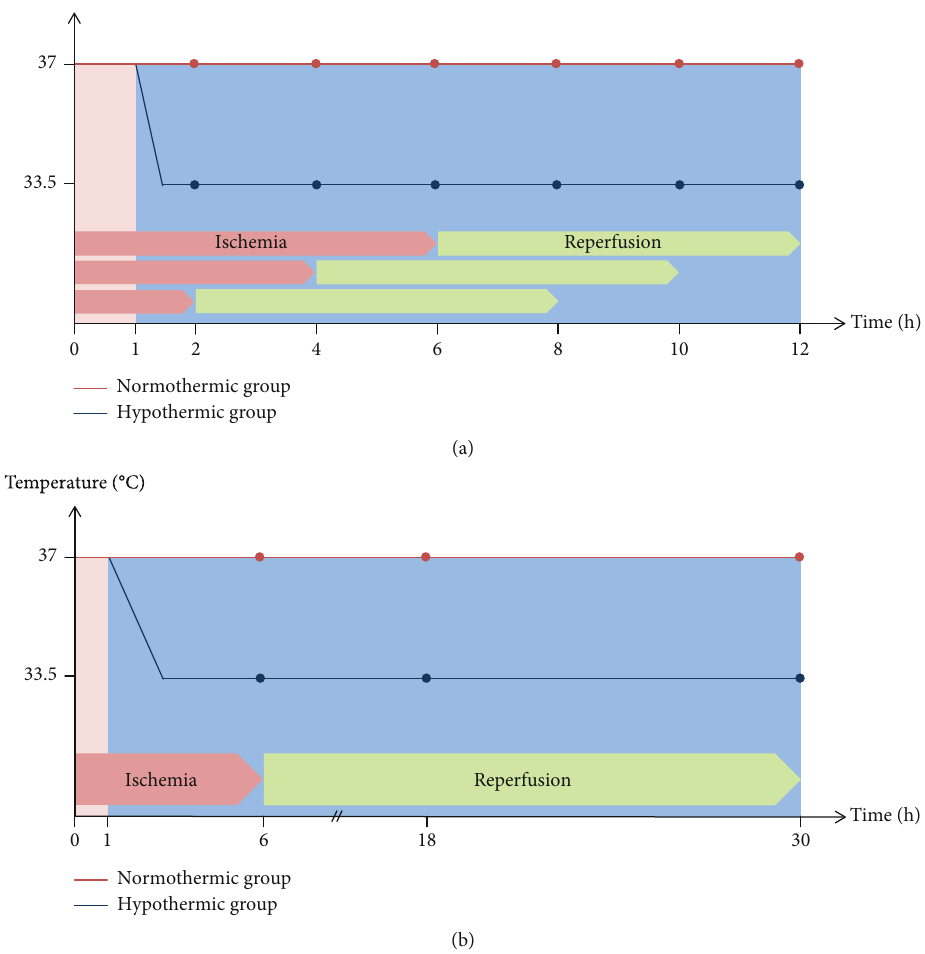
Figure 1: Experimental time-temperature protocol. Normothermic OGD/R-induced injury groups were maintained at 37 ° C for the duration of the experiment, while TTM-treated groups were cooled to 33.5 ° C after 1 hour exposure to OGD and maintained during the simulated reperfusion phase. Experimental samples were analyzed (a) directly after exposure to increasing duration of OGD (2-6h) and 6 hours of simulated reperfusion (8-12h after experimental start, respectively) or (b) directly after exposure to 6 hours OGD and 12 or 24 hours of simulated reperfusion (18 and 30h after experimental start,